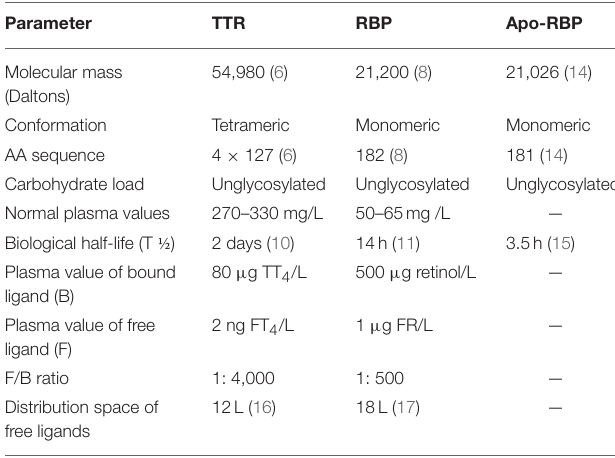
TABLE 1 | Main physico-chemical and metabolic characteristics of TTR, RBP, and Apo-RBP (Healthy reference man weighing